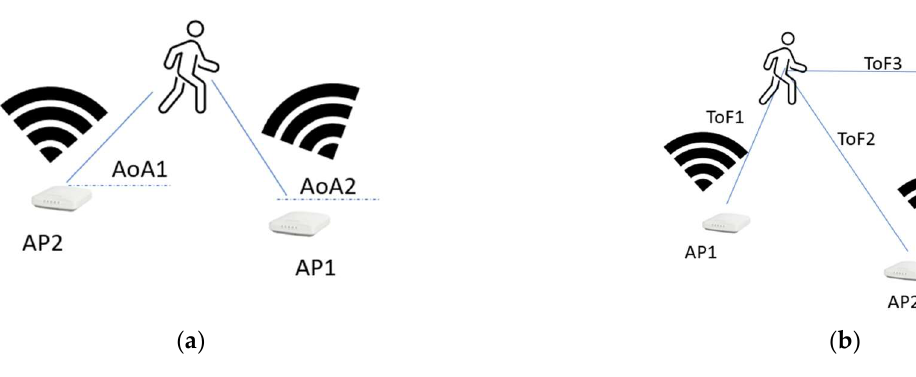
Figure 13. WiFi sensing with different situations; ( a ) using two APs and measuring Angle of Arrival (AoA); ( b ) Using 3 APs and measuring Time of Fly (ToF).